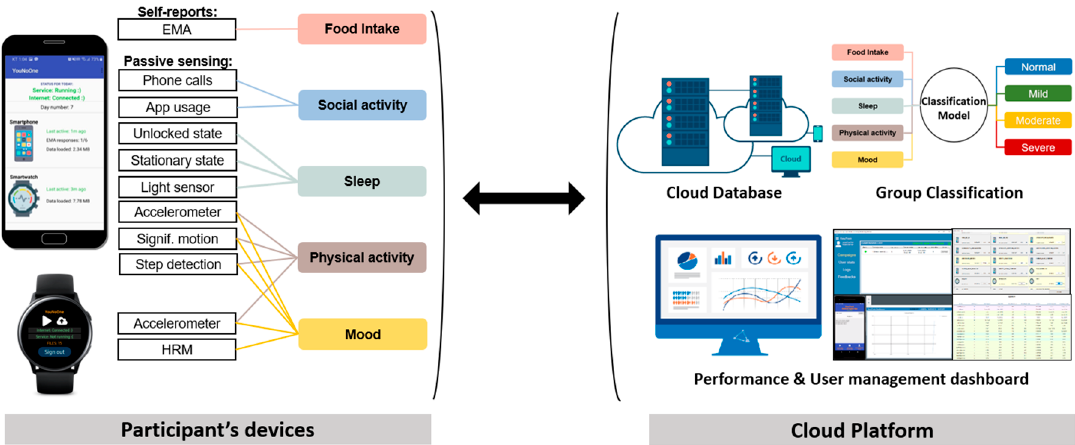
Figure 4. Short-Term Depression Detector (STDD) architecture: smartphone and smartwatch apps and cloud platform with dashboard.